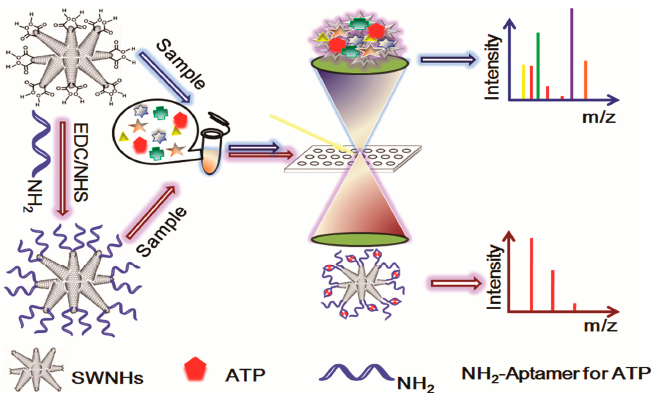
Figure 3. Schematic diagram of aptamer modification of single-walled carbon nanohorns (SWNHs) and negative ion laser desorption/ionization-time-of-flight mass spectrometry (LDI-TOF MS) analysis using functional SWNHs as matrix. Reproduced with permission of [81].